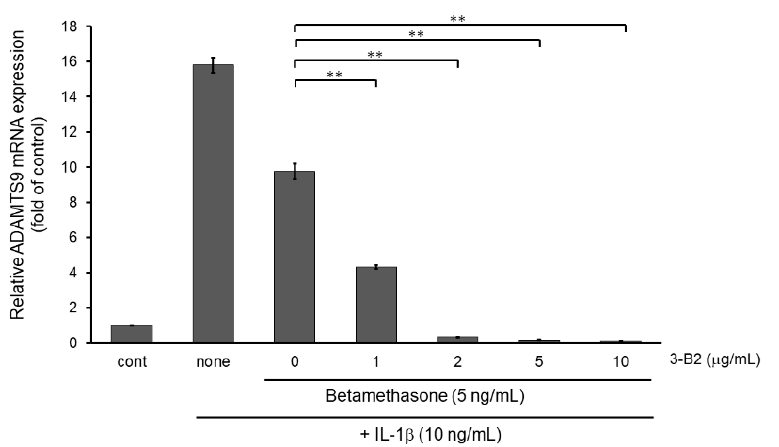
Figure 12. Additive effect of 3-B2 on attenuating ADAMTS9 mRNA expression with low dose of betamethasone in IL-1 β -stimulated OUMS-27 cells. Cells pretreated with various concentrations (1, 2, 5, 10 µ g/mL) of 3-B2 and betamethasone (5 ng/mL), followed by the stimulation with IL-1 β (5 ng/mL) for 6 h. Along with low dose of betamethasone, 3-B2 exhibited significant additive attenuating effect on ADAMTS9 mRNA expression in IL-1 β -stimulated OUMS-27 cells. Values represent mean ± SE ( n = 6 per group). ** p < 0.01.